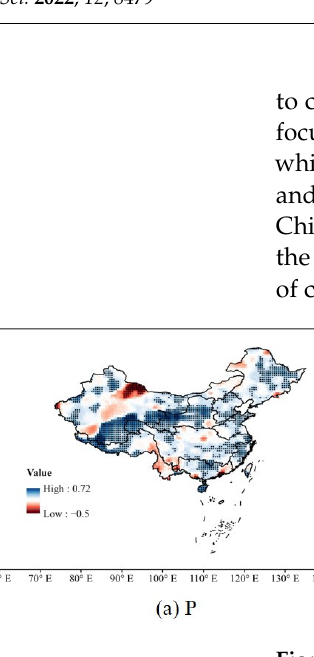
Figure 2. Spatiotemporal distribution of the long-term trends of P, PET, and D series. Black dots indicate confidence levels of 95% or more.